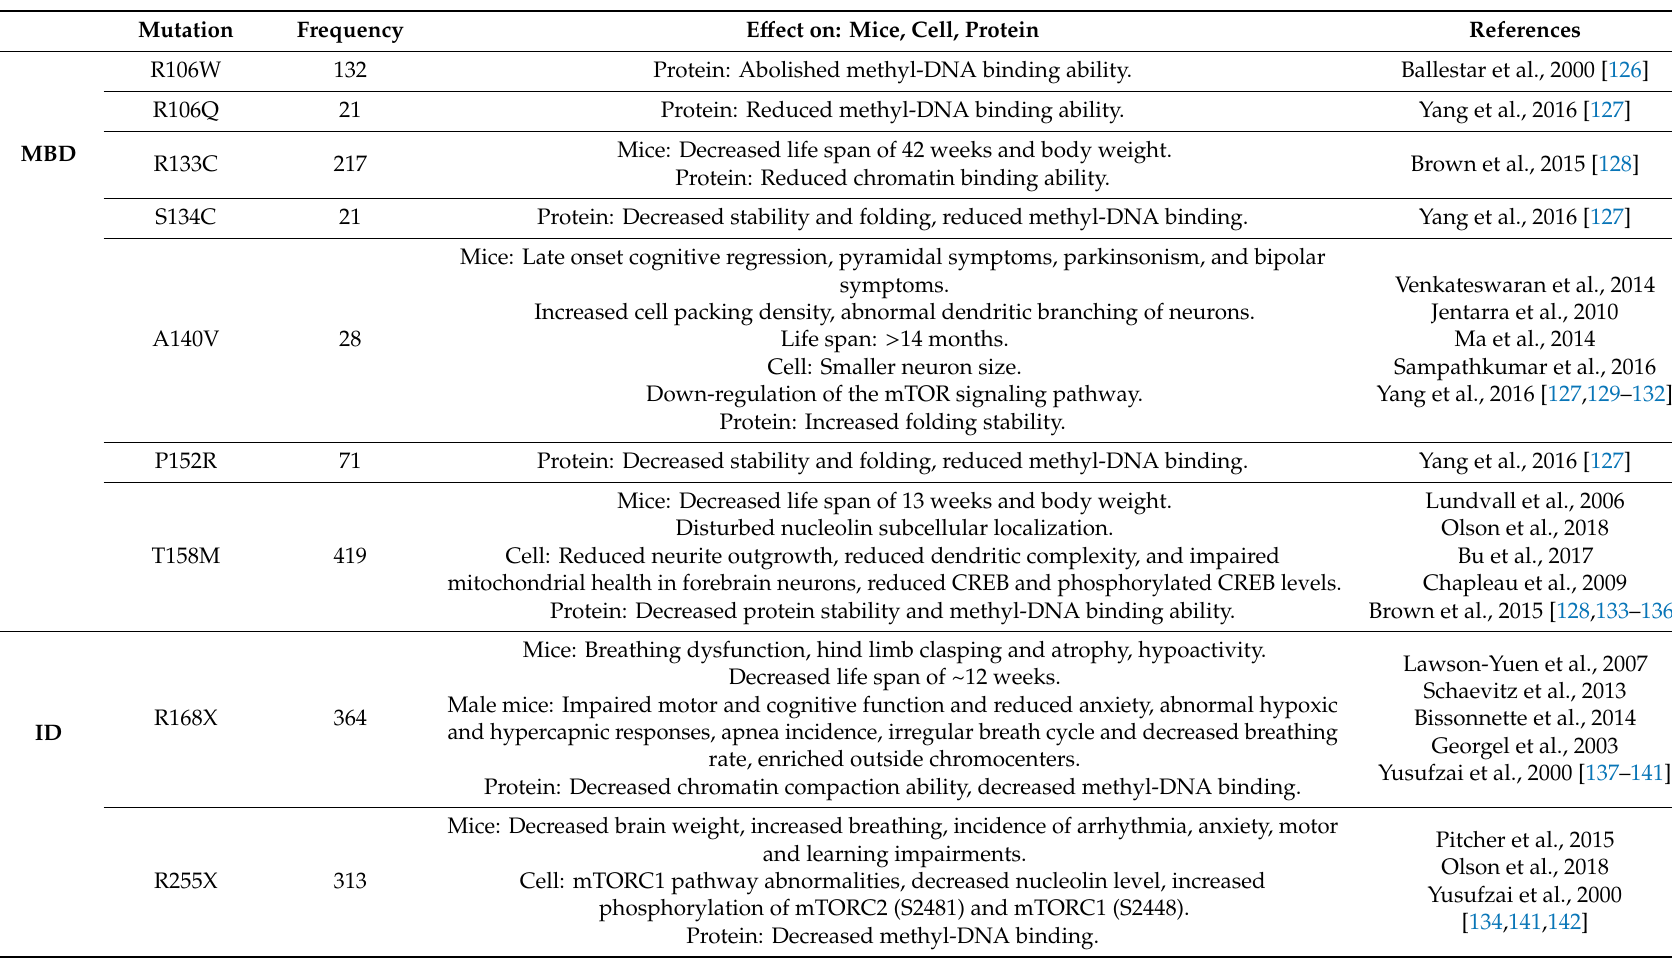
Table 3. Summary of high frequency RTT-related MeCP2 point mutations and